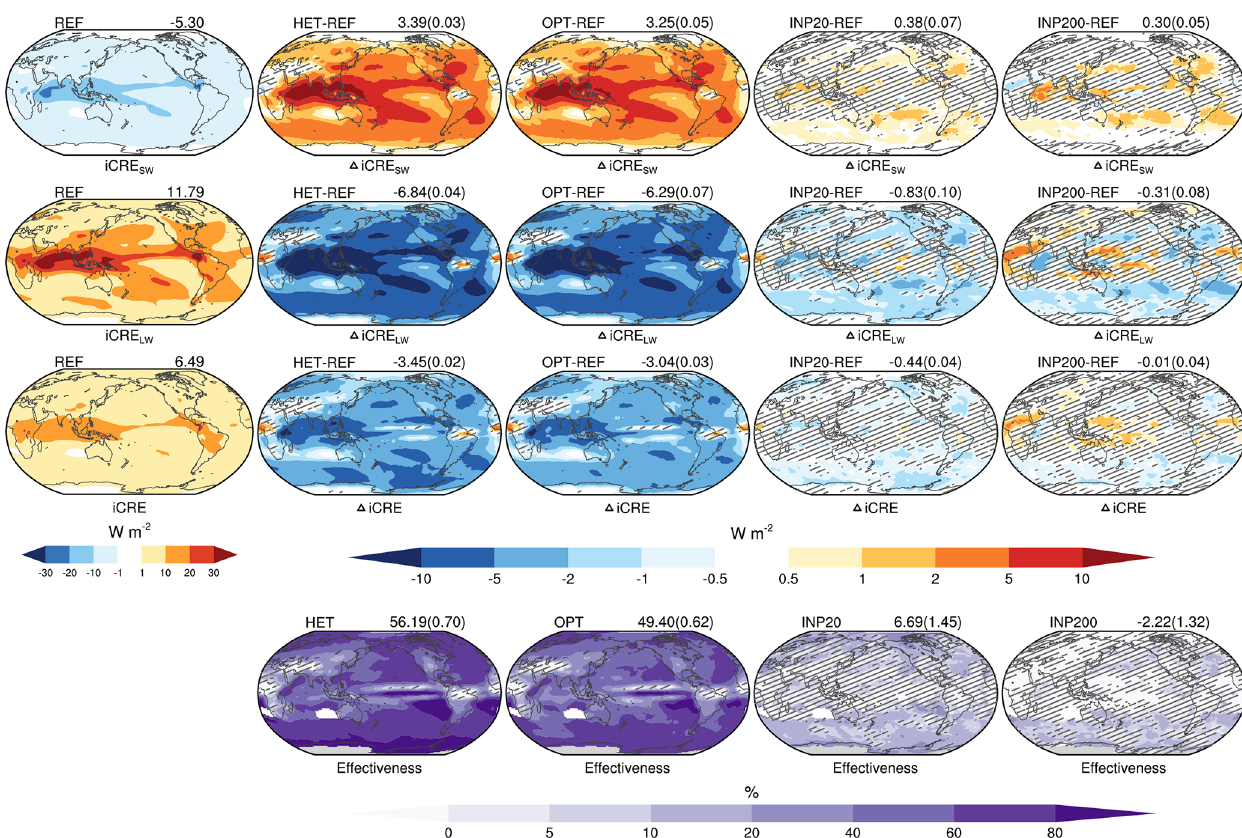
Figure 4. The annual mean spatial distribution of ice cloud shortwave radiative effect (iCRE SW , first row), ice cloud longwave radiative effect (iCRE LW , second row), ice cloud radiative effect (iCRE = iCRE SW + iCRE LW , third row), and cirrus seeding effectiveness (fourth row) from the REF experiment (first column) and the differences (“ (cid:49) ”) from the HET, OPT, INP20, and INP200 experiments with respect to the REF experiment (second to fifth columns). Note that regions with absolute value of iCRE < 1.0Wm − 2 from the REF experiment are excluded for calculating cirrus seeding effectiveness. Global mean values are shown in the upper right corner, and the corresponding standard deviations calculated from the difference of each year for 10 years are shown in brackets. The shadow denotes that the differences between two experiments are not significant at the 95% level based on Student’s t